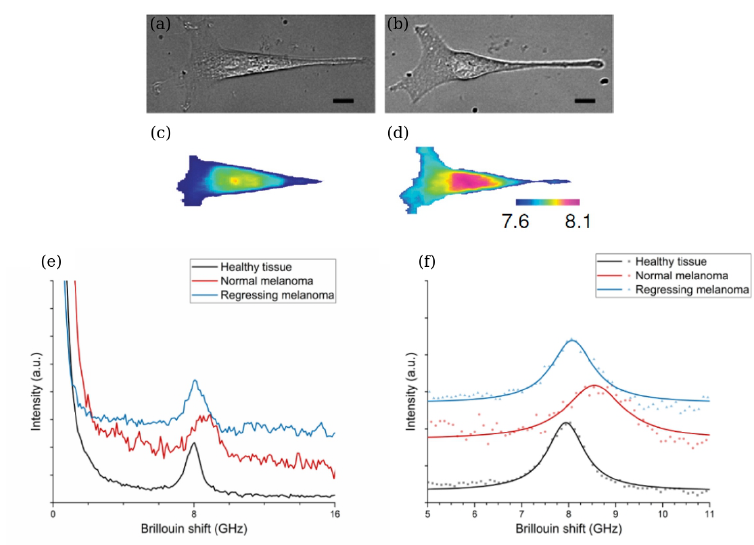
Figure 7. ( a , b ) Phase-contrast microscopy and ( c , d ) co-registered BLS spectrospcopy-based images of a mouse fibroblast cell before ( a , c ) and after ( b , d ) a hyperosmotic shock. The scale bars of the phase contrast images are 10 µ m. The false colour map of the BLS-based images encode the measured Brillouin frequency shifts in the range from 7.6 to 8.1GHz. Reproduced from [139] under the terms of a Creative Commons Attribution (CC-BY) License. ( e ) Representative anti-Stokes Brillouin peaks of the BLS spectra obtained for a healthy tissue (black curve), normal non-regressing melanoma (red curve) and regressing melanoma (blue curve). ( f ) Close-up view of the spectra shown in panel ( e ): dots correspond to the raw experimental data and lines show the respective Lorentzian function fit of the raw data. Reproduced from [23]. Copyright 2019 Optical Society of America under the terms of the OSA Open Access Publishing